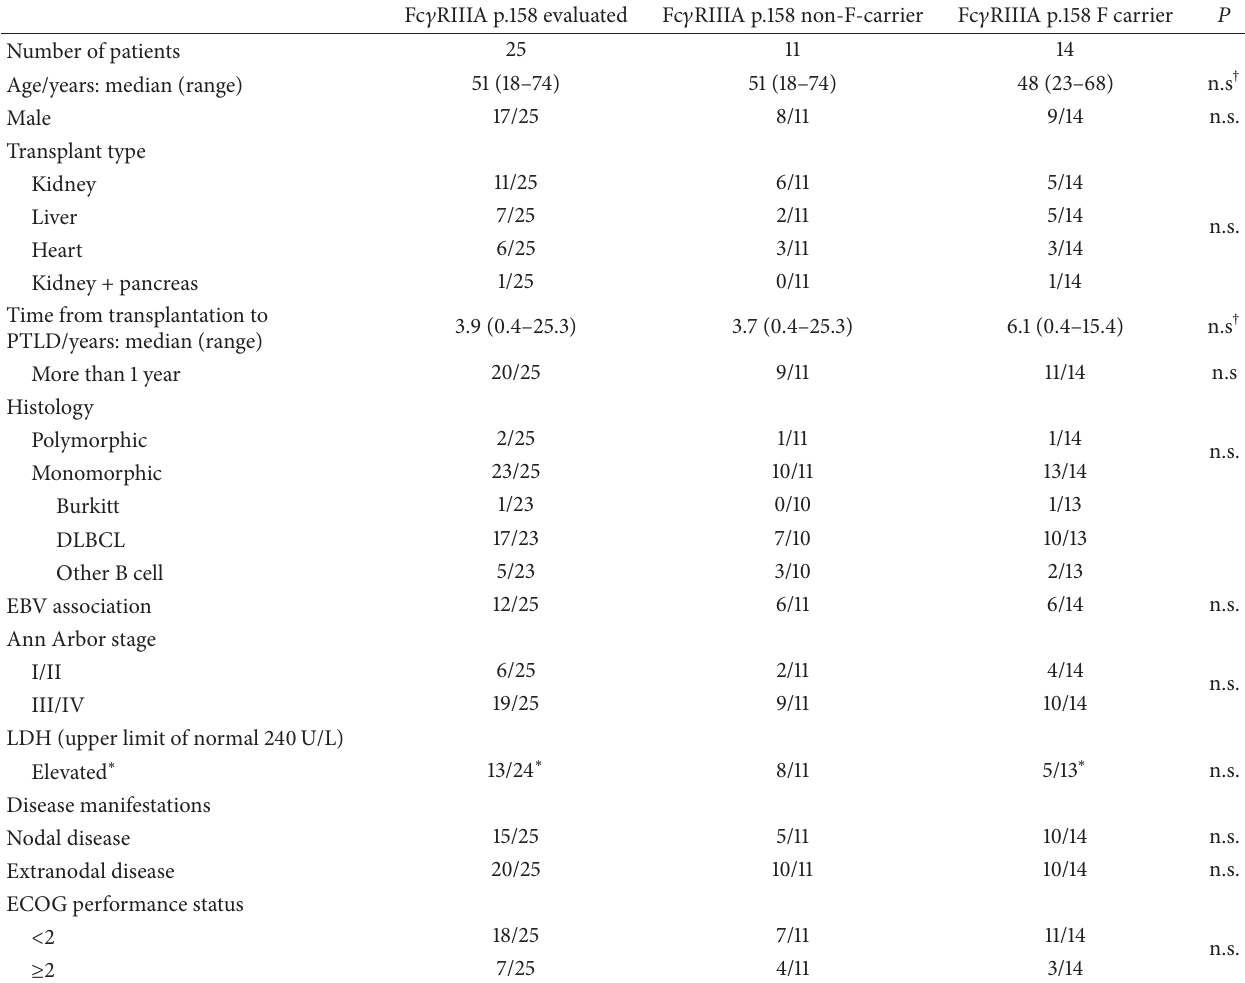
Table 1: Patient’s baseline characteristics.